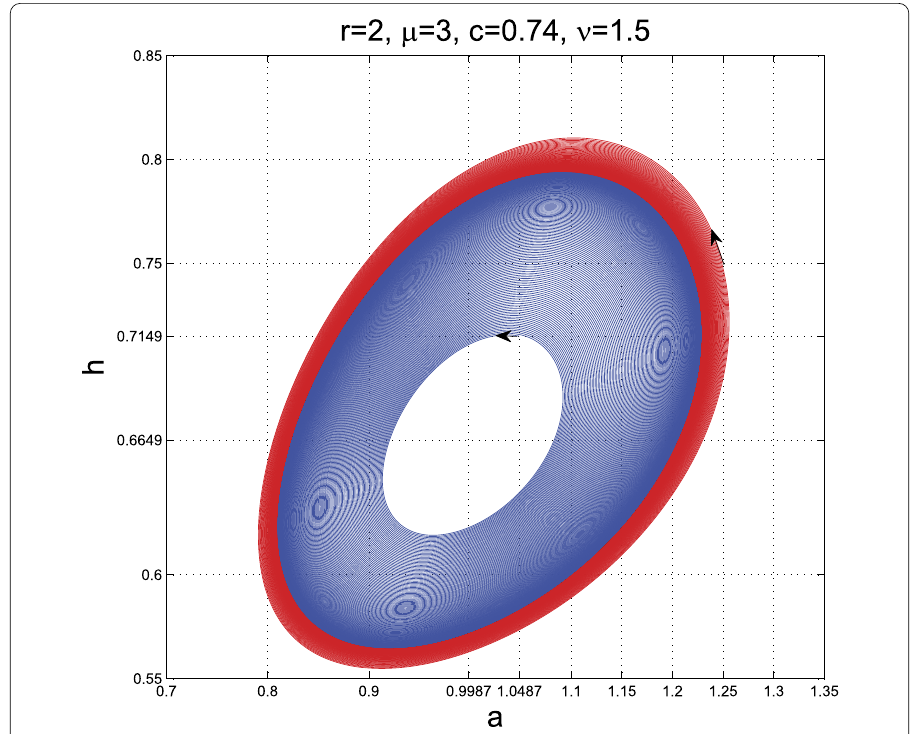
Figure 3 The orbits converse to the limit cycle. The phase orbits starting from ( a 0 , h 0 ) = (1.0487,0.7149) and ( a 0 , h 0 ) = (1.25,0.75) both converge to the stable limit